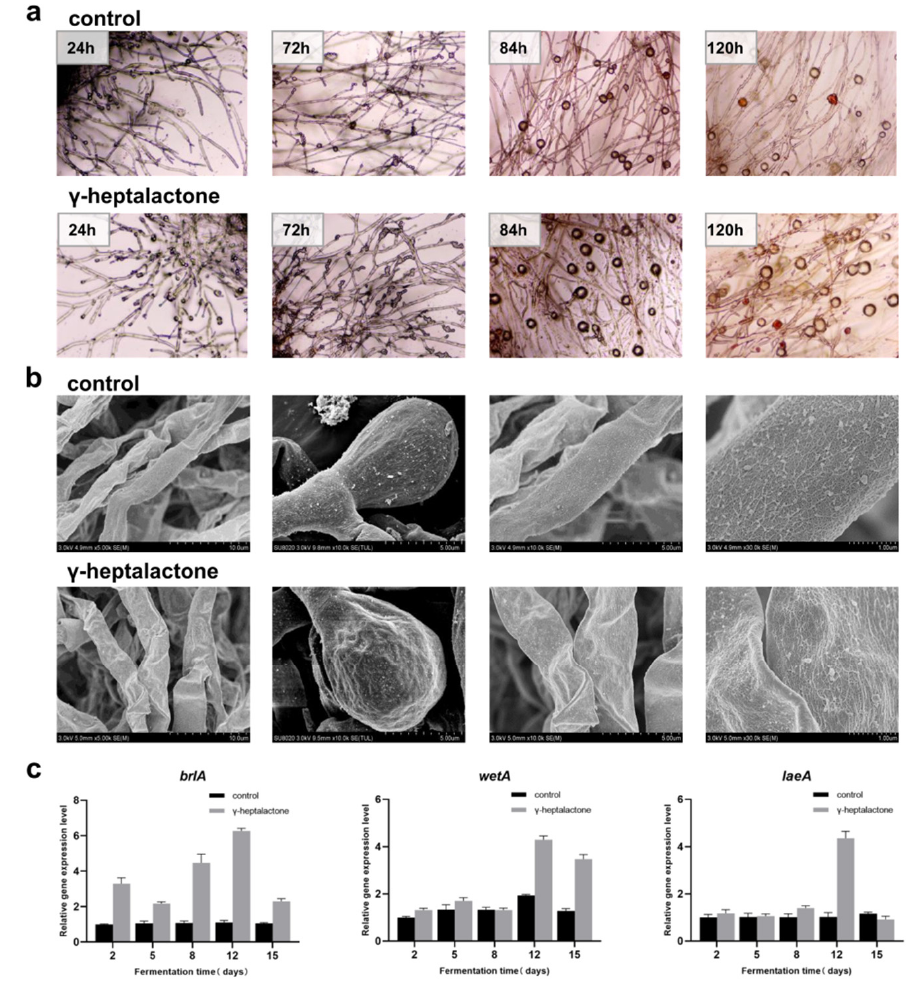
Figure 5. Effect of γ -heptalactone on micromorphology and the expression of asexual development genes of the M. purpureus M1. ( a ) Morphology of the M. purpureus after cultivation on PDA at 30 °C for 120 h (at 400 × magnifications). ( b ) Scanning electron microscope images of the mycelium and spores at 5000 × , 10,000 × , and 30,000 × . ( c ) Relative expression levels of laeA , brIA , and wetA based on RT-qPCR.